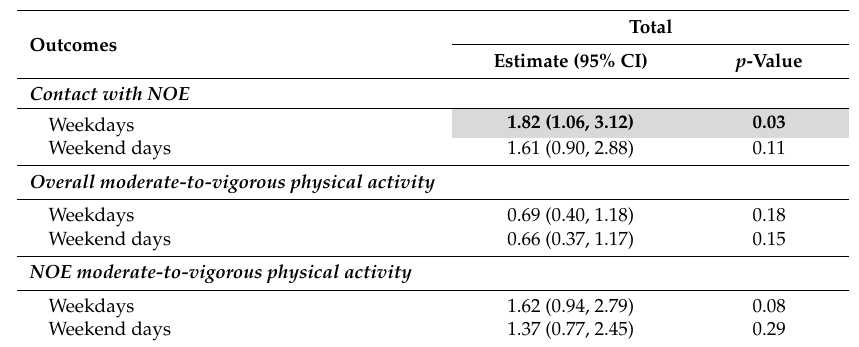
Table A7. Sensitivity models. Adjusted models for residential NOE availability defined as presence/ absence of green spaces at 150 m Euclidean buffer.